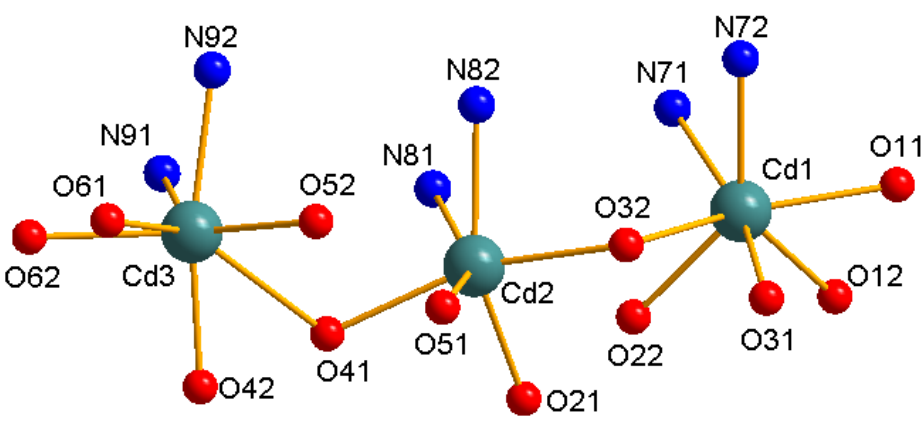
Figure 4. The coordination options of carboxylates in the Cd (II)